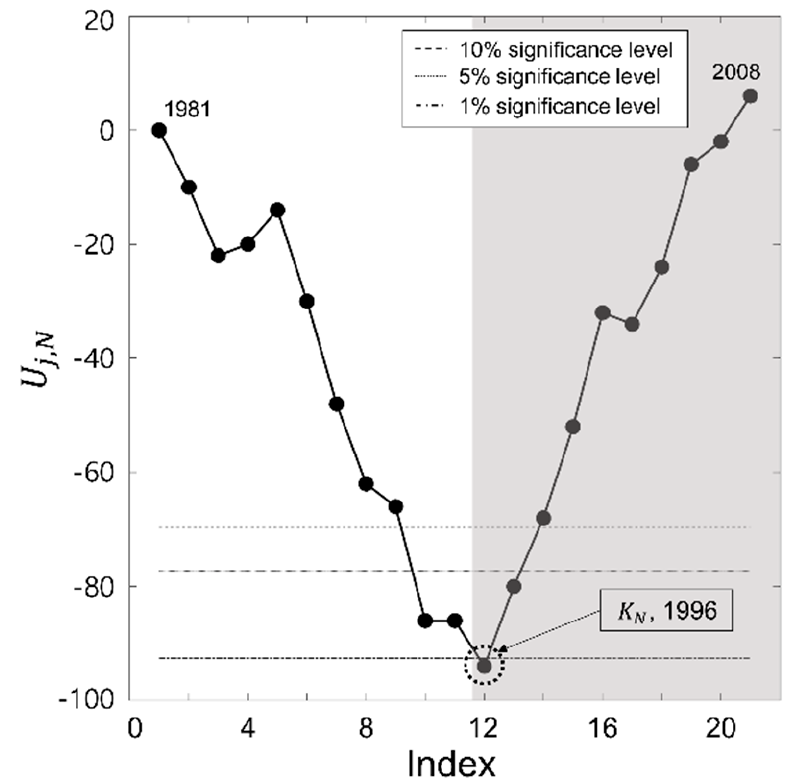
Figure 5. Pettitt’s test of the GCP forest catchment based on annual rainfall-runoff data from 1981 to 2008. The test statistic corresponding to 1996 falls in the rejection region ( p = 0.008), which means that runoff characteristics changed after 1996 and were statistically significant.